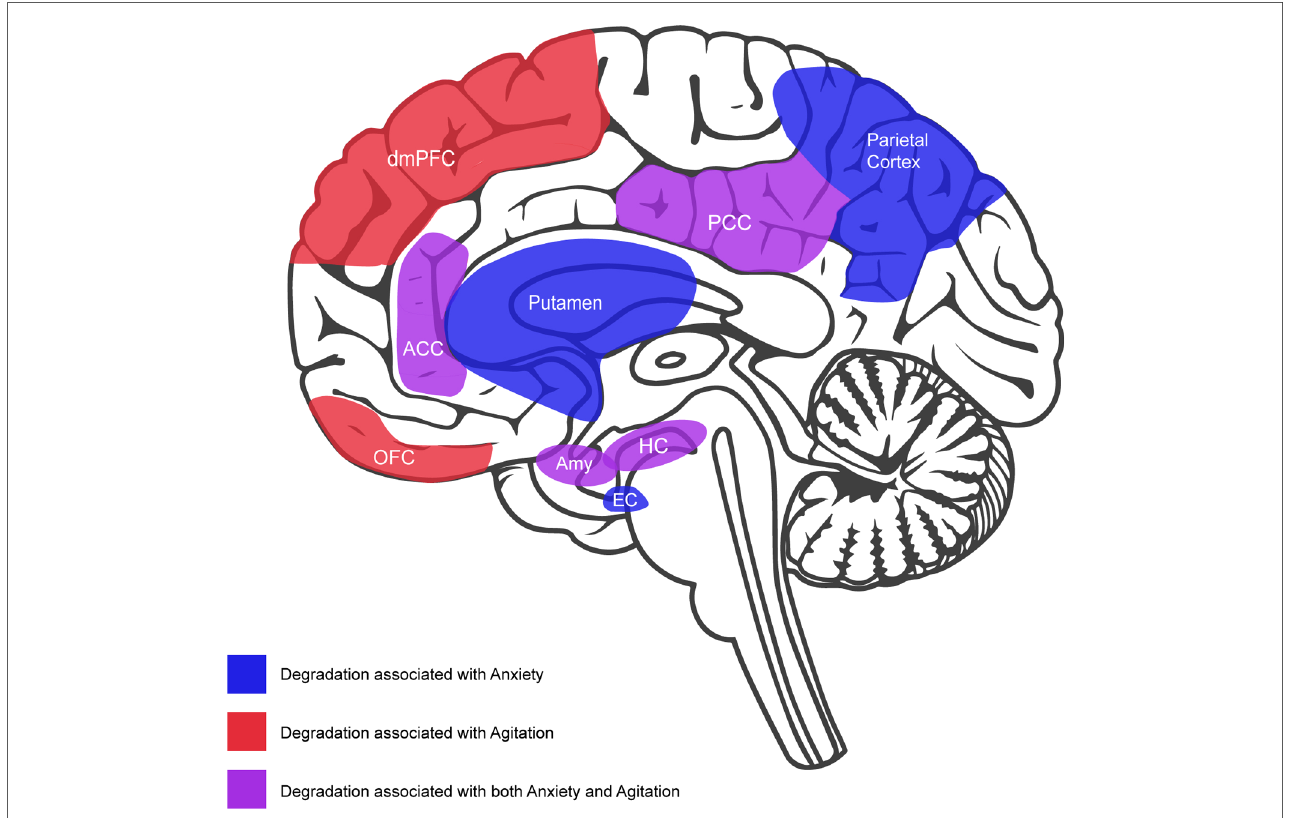
FIGURE 1 Midsaggital view of brain featuring neural degradation that has been associated with anxiety and agitation in dementia: anxiety (blue)=putamen, parietal cortex, and entorhinal cortex (EC); agitation (red)=orbitorfrontal cortex (OFC); dorsolateral prefrontal cortex (dmPFC); anxiety and agitation (purple)= anterior cingulate cortex (ACC), posterior cingulate cortex (PCC), amygdala (Amy), hippocampus (HC), and insula (not depicted in this